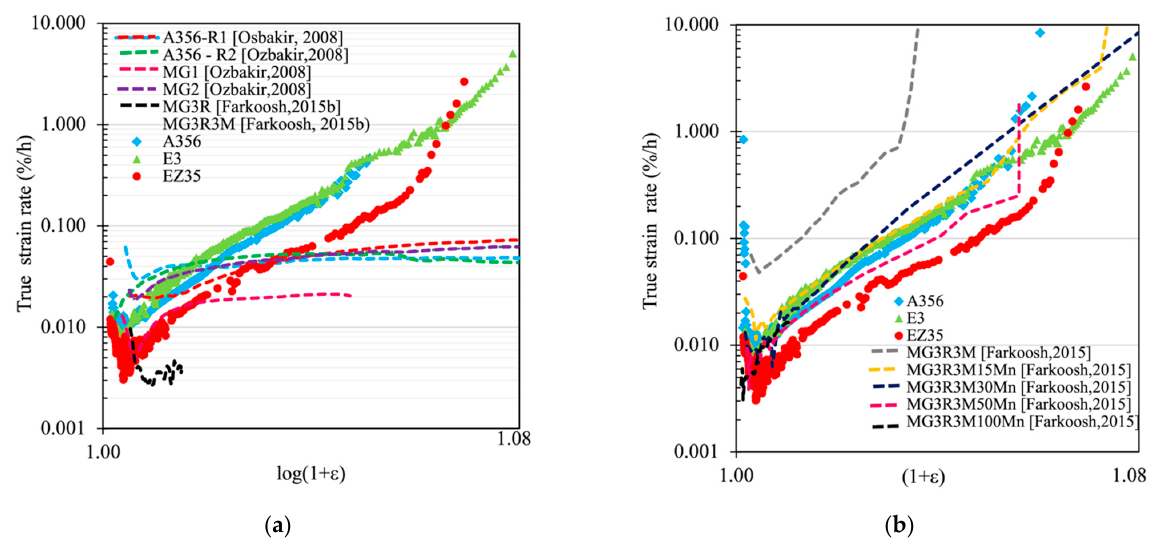
Figure 10. ( a ) Comparison between the results of the tensile creep tests performed on A356, E3 and EZ35 alloys and those reported by Ozbakir [52] and Farkoosh [51] for a A356 alloy and modified versions in microstructural conditions men- tioned within the text. ( b ) Comparison between the results of the tensile creep tests performed on A356, E3 and EZ35 alloys and those reported by Farkoosh [39] for modified versions of the A356 alloy in microstructural conditions mentioned within the text.